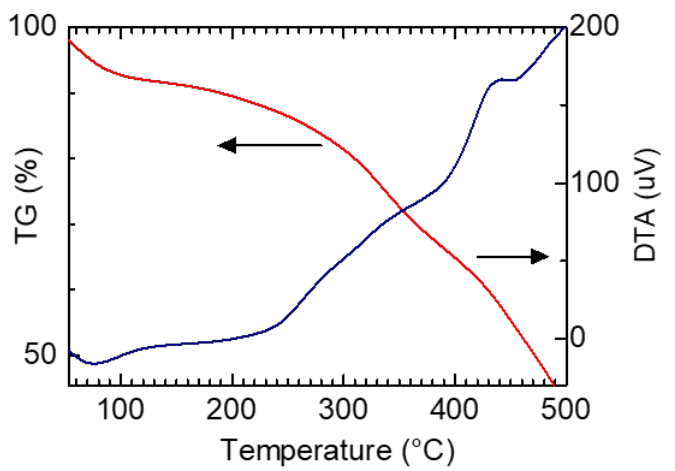
Figure 9. Thermogravimetric (TG) analysis and differential thermal analysis (DTA) measurement results of